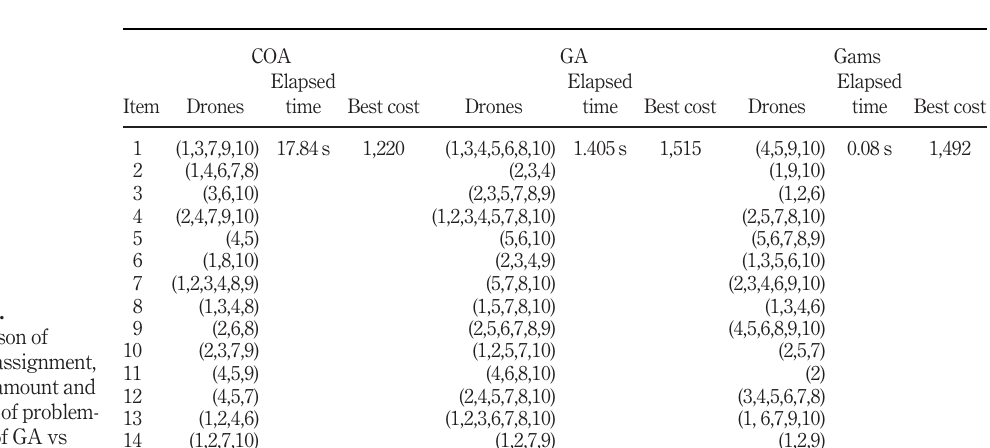
Table 5. Comparison of optimal assignment, optimal amount and duration of problem- solving of GA vs